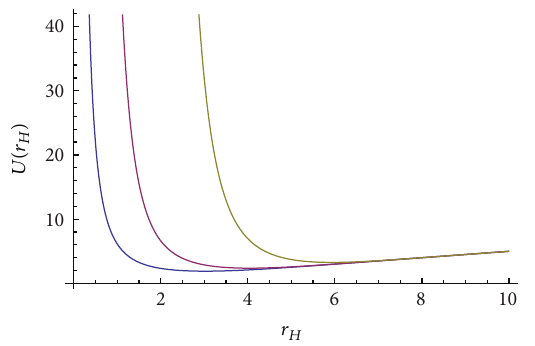
Figure 3: Plot of 𝑔 00 (𝑟) as a function of 𝑟 in √𝜃 -units for fixed value Figure 4: Plot of 𝑈(𝑟 𝐻 ) as a function of 𝑟 𝐻 in √𝜃 -units for 𝑘 = 0 of 𝑘 = 1 and different values of the mass 𝑀 ; that is, 𝑀 = 1 (blue), (blue), 𝑘 = 1 (magenta), and 𝑘 = 4 𝑀 = 5 (brown). Here, 𝑀 ≃ 2.36976 is the 𝑀 = 𝑀 𝑒 (magenta), and 𝑒 extremal mass for the case 𝑘 = 1 .